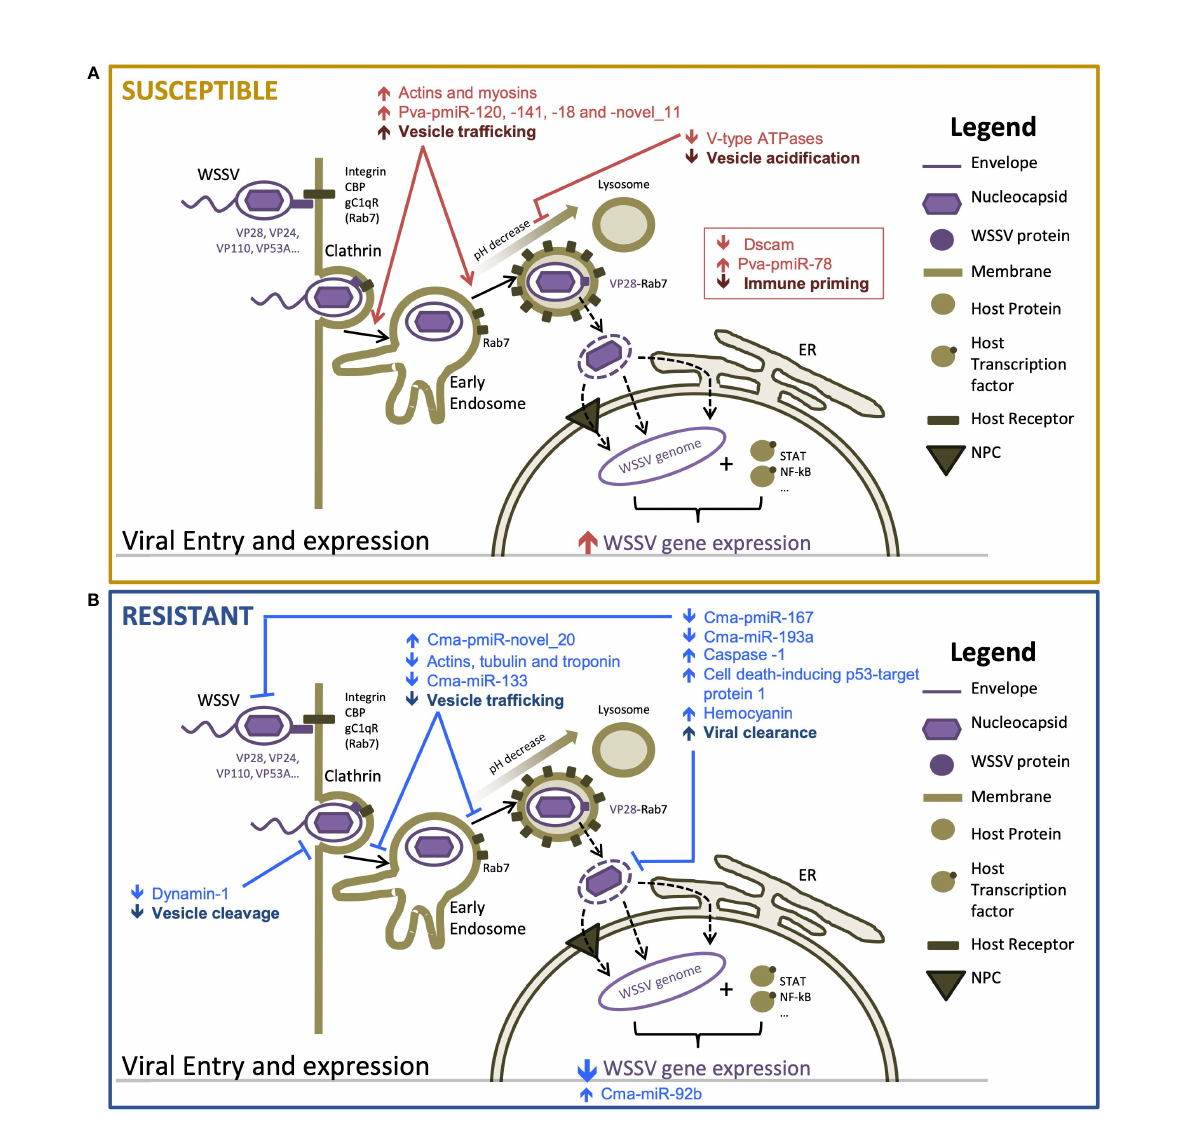
FIGURE 4 Proposed mechanisms responsible for differences in susceptibility to WSSV between resistant and susceptible hosts [adapted from Verbruggen et al. (61)] (A) highly susceptible Penaeus vannamei and (B) highly resistant Carcinus maenas . Host components are displayed in brown tones and viral components are displayed in purple tones. Arrows indicate the direction of change in transcription or activity of a proposed process. Differential responses of susceptible and resistant hosts are shown in red and blue,